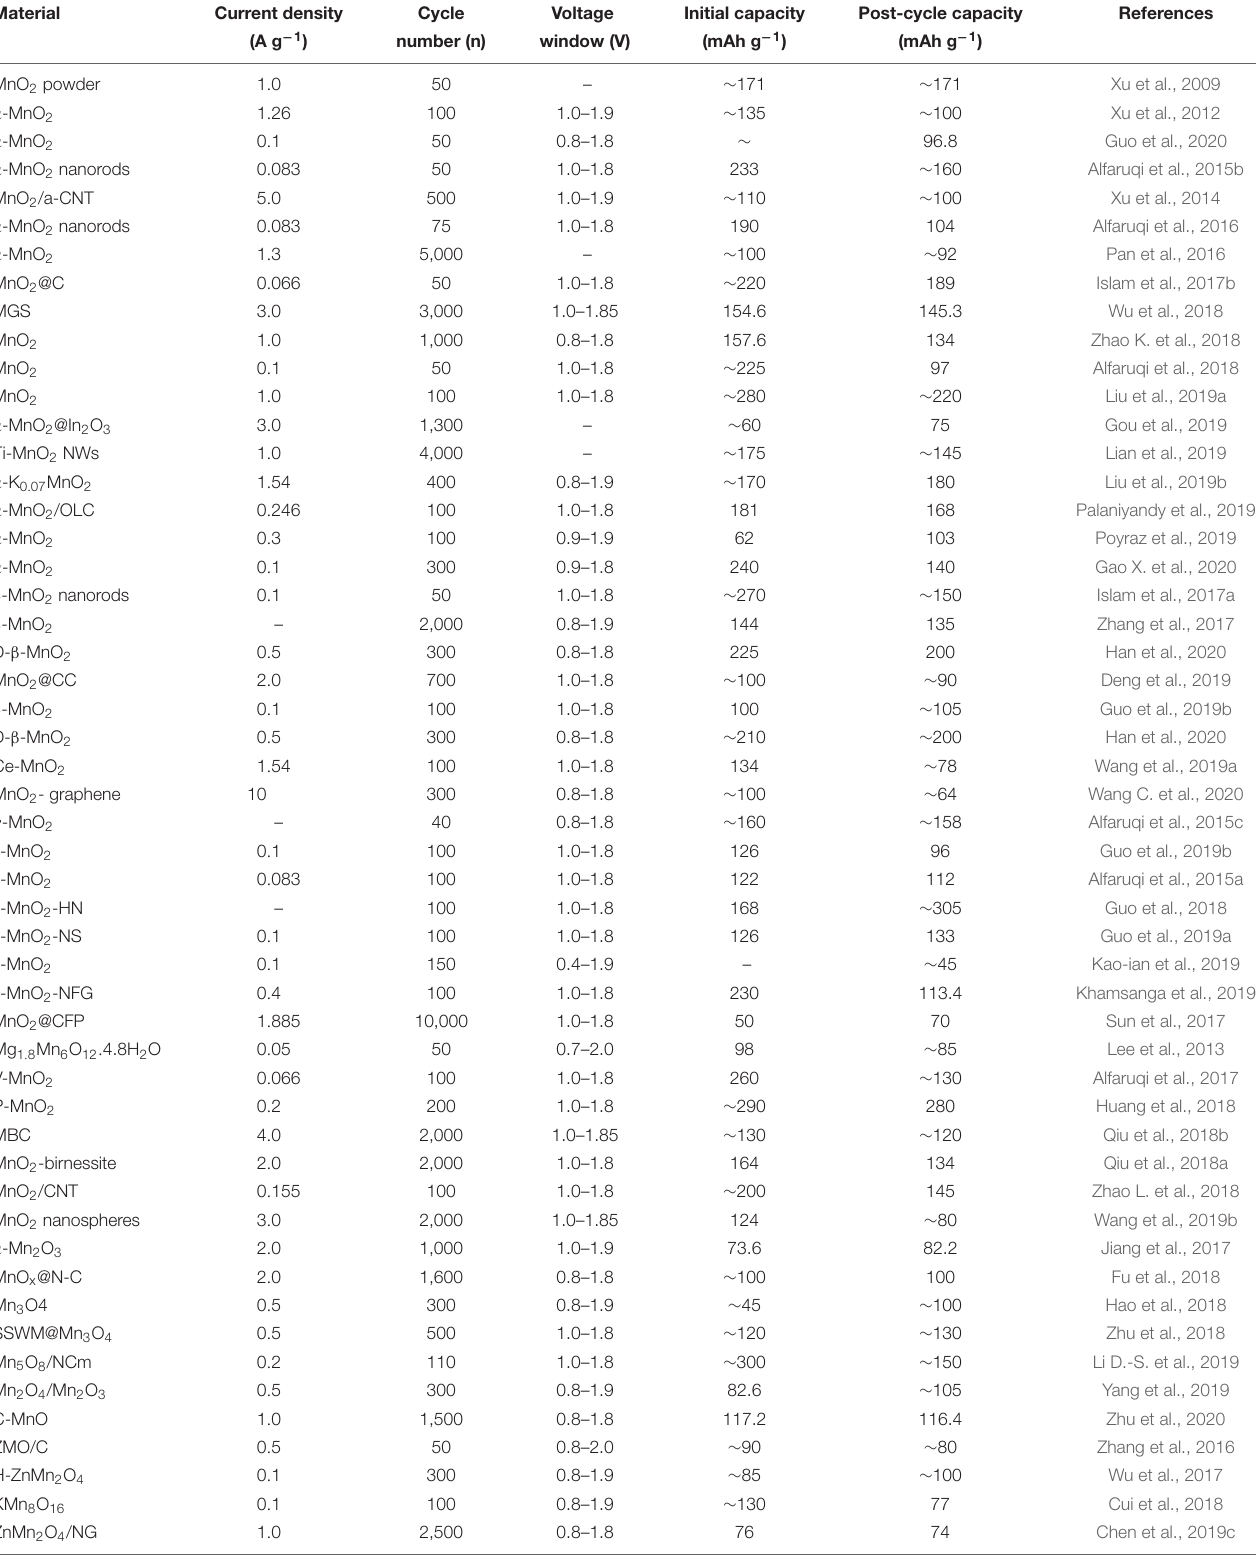
TABLE 1 | Electrochemical performance of manganese-based materials as cathode materials for AZIBs. Material Current density Cycle Voltage